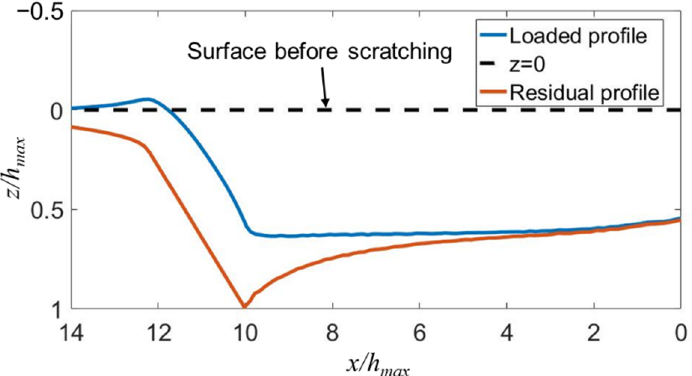
Figure 7. The FEA-simulated profiles of the scratching impression at the fully loaded and fully unloaded states for an edge-forward Berkovich indenter.